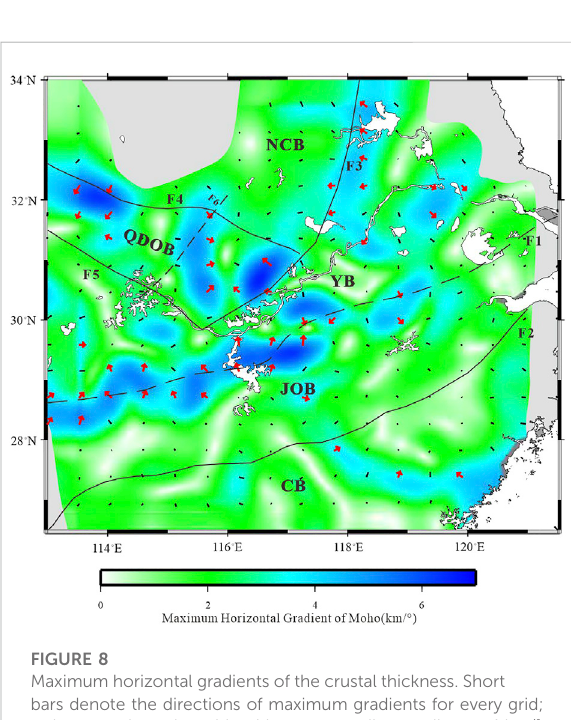
FIGURE 8 Maximum horizontal gradients of the crustal thickness. Short bars denote the directions of maximum gradients for every grid; red arrows show the grids with corresponding gradients > 4 km/ ° . The direction indicatedby thearrowindicatesthat thecrustal thickness increases. Labels are the same as in Figure